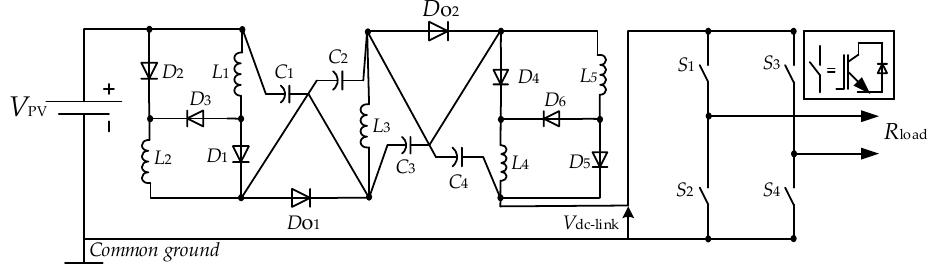
Figure 2. Proposed switched inductor assisted strong boost Z-source inverter (SL-SBZSI).